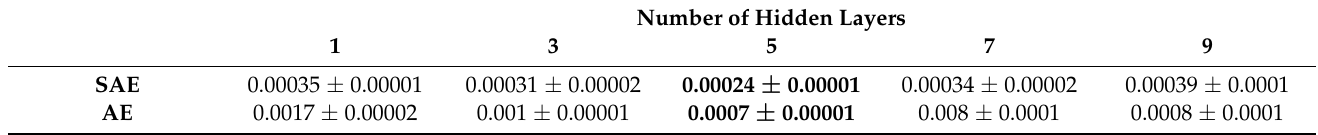
Table 2. Effect of number of hidden layers on the performance (MSE) of SAE and AE. Number of Hidden Layers